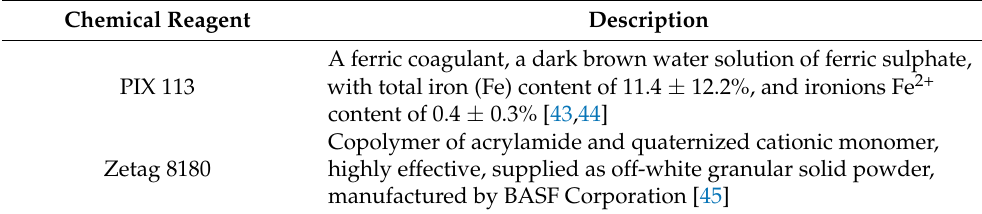
Table 1. Characteristics of the chemicals used in the test.